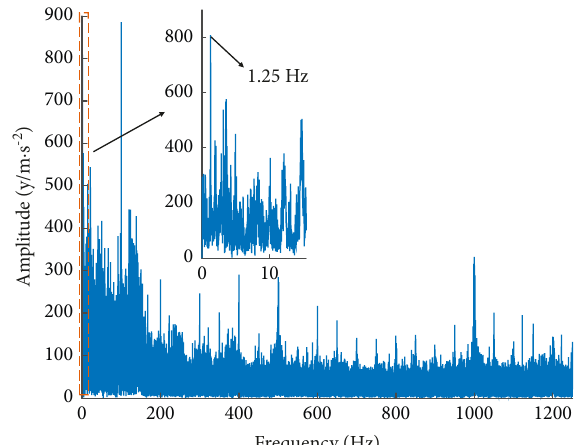
Figure 5: Spectrum of measured vertical acceleration at hinge